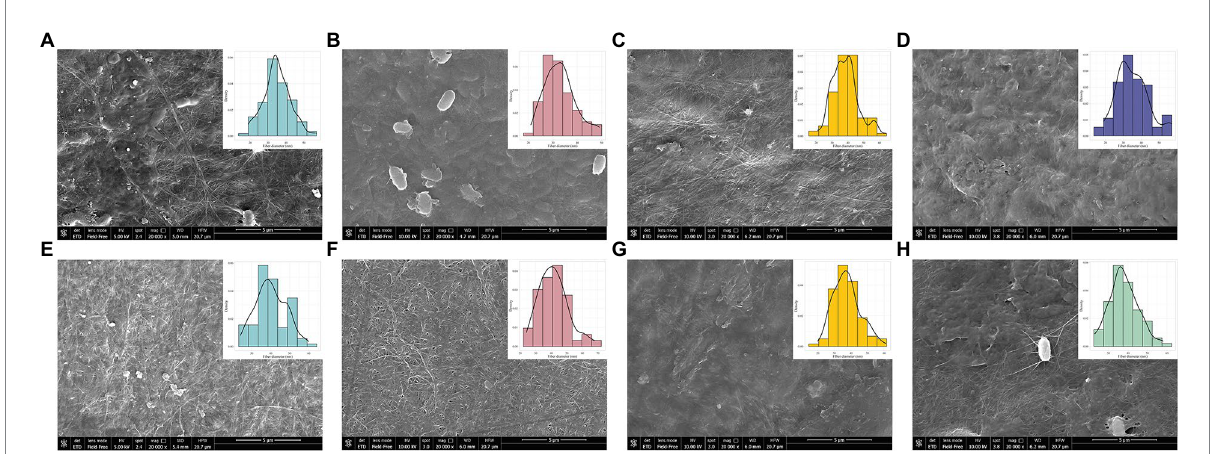
FIGURE 5 BC morphology characterization among conditions by using SEM. The characterization was performed considering cycle 1 and cycle 30 for (A–E) MA, (B–F) MG and (C–G) MF conditions. Only sample from the cycle 1 were assayed for (D) GC and (H) MC